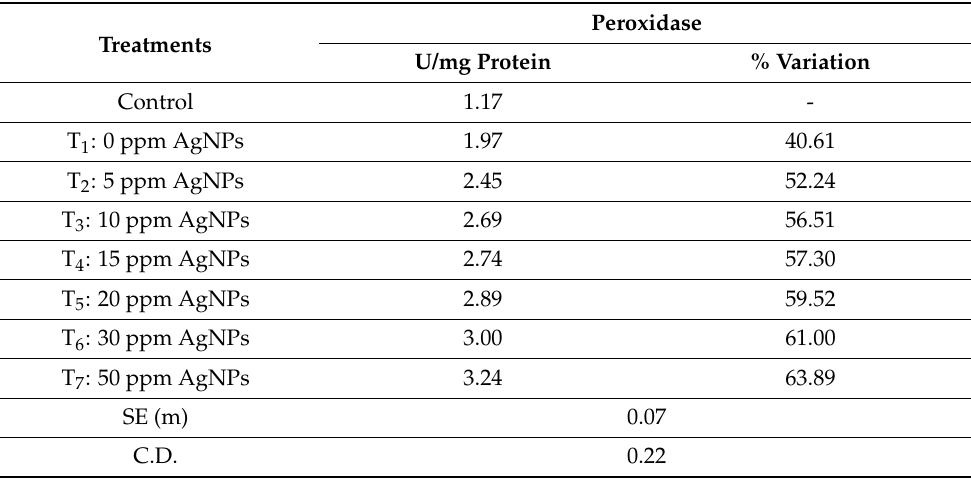
Table 6. Estimation of Peroxidase activity in spot blotch infected wheat plant leaves in response to nanoparticle treatment.